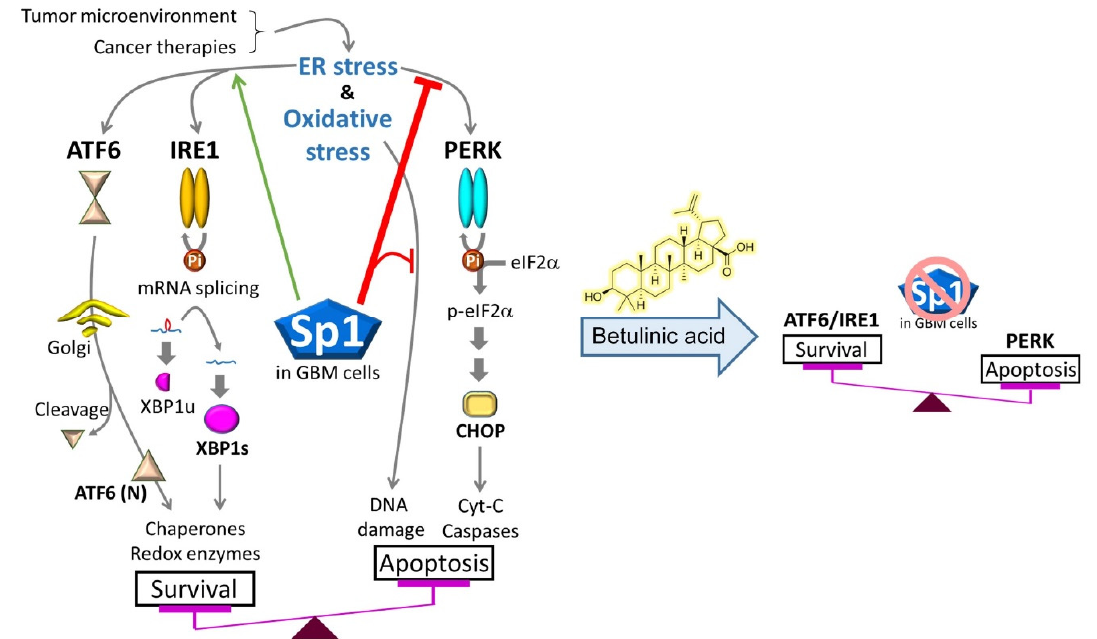
Figure 8. Sp1 protects malignant GBM cells against cancer therapies by altering ER/oxidative-stress responses, particularly inhibition of protein kinase RNA-like endoplasmic reticulum kinase (PERK)/eIF2 α / C/EBP-homologous protein (CHOP) activation. However, BA also reduces Sp1 expression, thereby promoting apoptotic cell death in GBM.